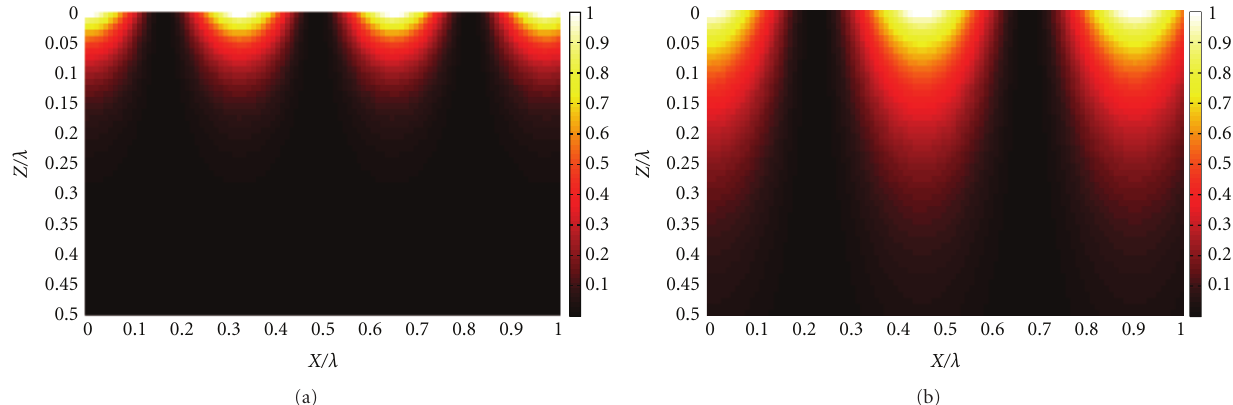
Figure 6: Electric field intensity profiles below a 7 nm-27nm-7nm Al-Al 2 O 3 -Al stack (left) and 20 nm Al film (right) deposited on a quartz prism.